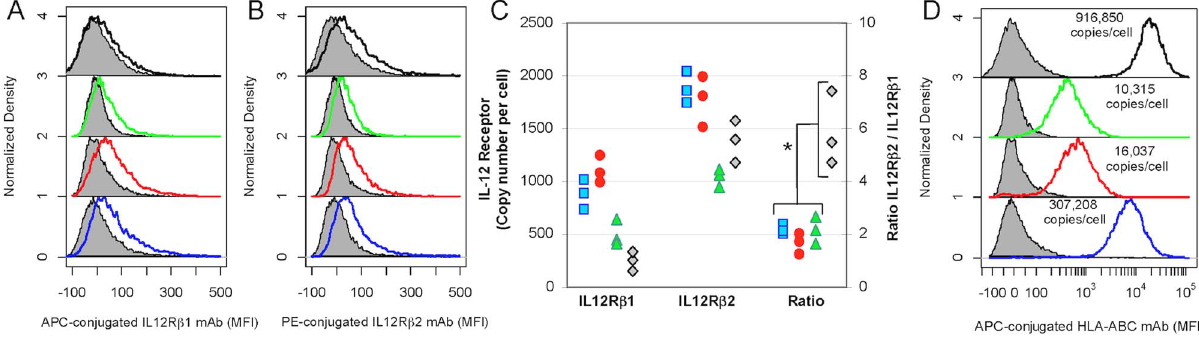
Figure 5. Basal copy numbers of IL12RB1, IL12RB2, and MHC class I in breast cancer cell lines were consistent with cohort group assignment based upon molecular pathology. Copy numbers of membrane proteins IL12RB1 (A), IL12RB2 (B) and HLA-ABC (D) were quantified using flow cytometry for four breast cell lines: 184A1 HMECs (blue), BT474 (HER2 + /ER + /PR + ) cells (red), SKBR3 (HER2 + /ER 2 /PR 2 ) cells (green), and MDA-MD-231 (HER2 2 /ER 2 /PR 2 ) cells (black). Unstained cells are shaded in gray. Results are representative of three independent replicates. (C) The ratio of IL12RB2/IL12RB1 was increased in MDA-MB-231 cells relative to the other three cell lines (* indicates a p-value , 0.05, as estimated using an unpaired two-tailed Student’s t-test).